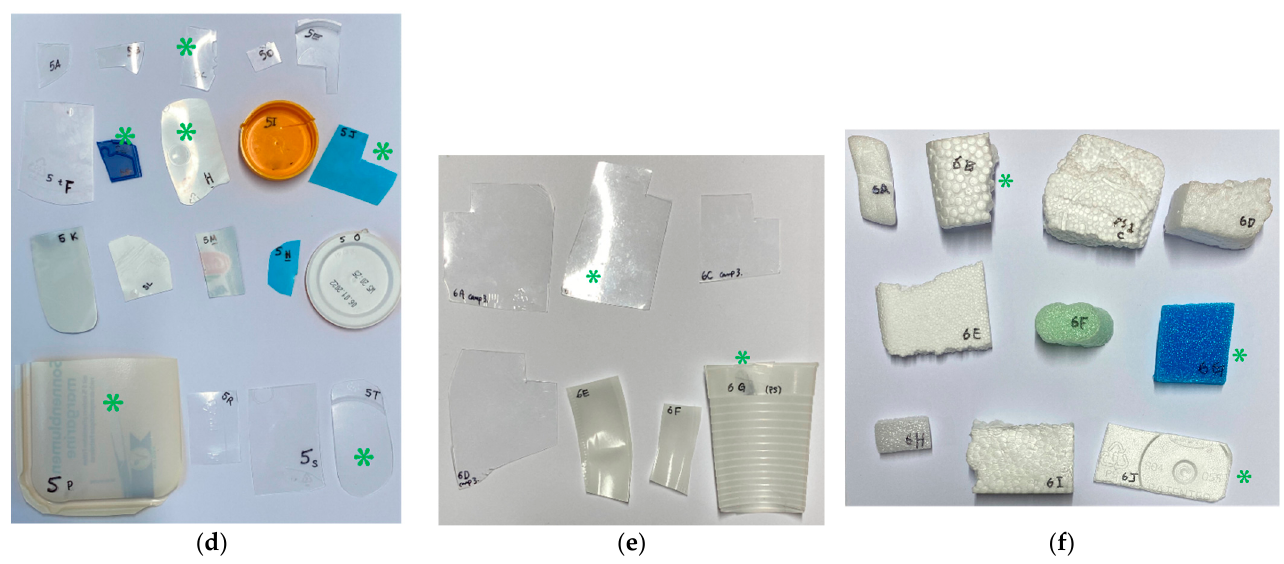
Figure A1. Photograph showing the appearance of samples measured for the plastic classification experiment. ( a ) type 1 PET; ( b ) type 2 HDPE (dark blue sample that resulted in low reflectance is circled in red); ( c ) type 4 LDPE; ( d ) type 5 PP; ( e ) type 6 PS; and ( f ) type 6 foam. The green stars indicate the samples that were used in the test set.